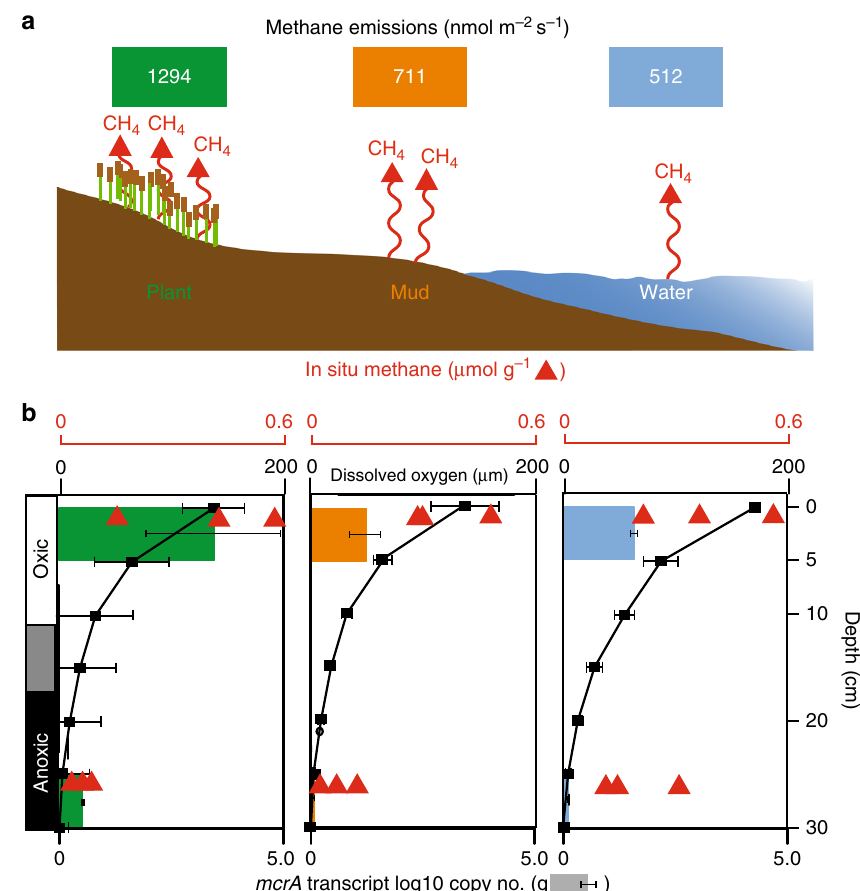
Fig. 2 The relationship between soil dissolved oxygen concentration and methanogenic activity with depth and ecosites from Summer. a Schematic of the three ecosites examined in this study with methane emissions shown in colored boxes and depicted by red lines (Supplementary Fig. 2A). b Dissolved oxygen concentrations (black boxes), transcripts for mcrA (colored bars), and porewater methane concentrations (red triangles) in soils. Error bars re fl ect s.e. ( mcrA ) and s.d. (oxygen); n =